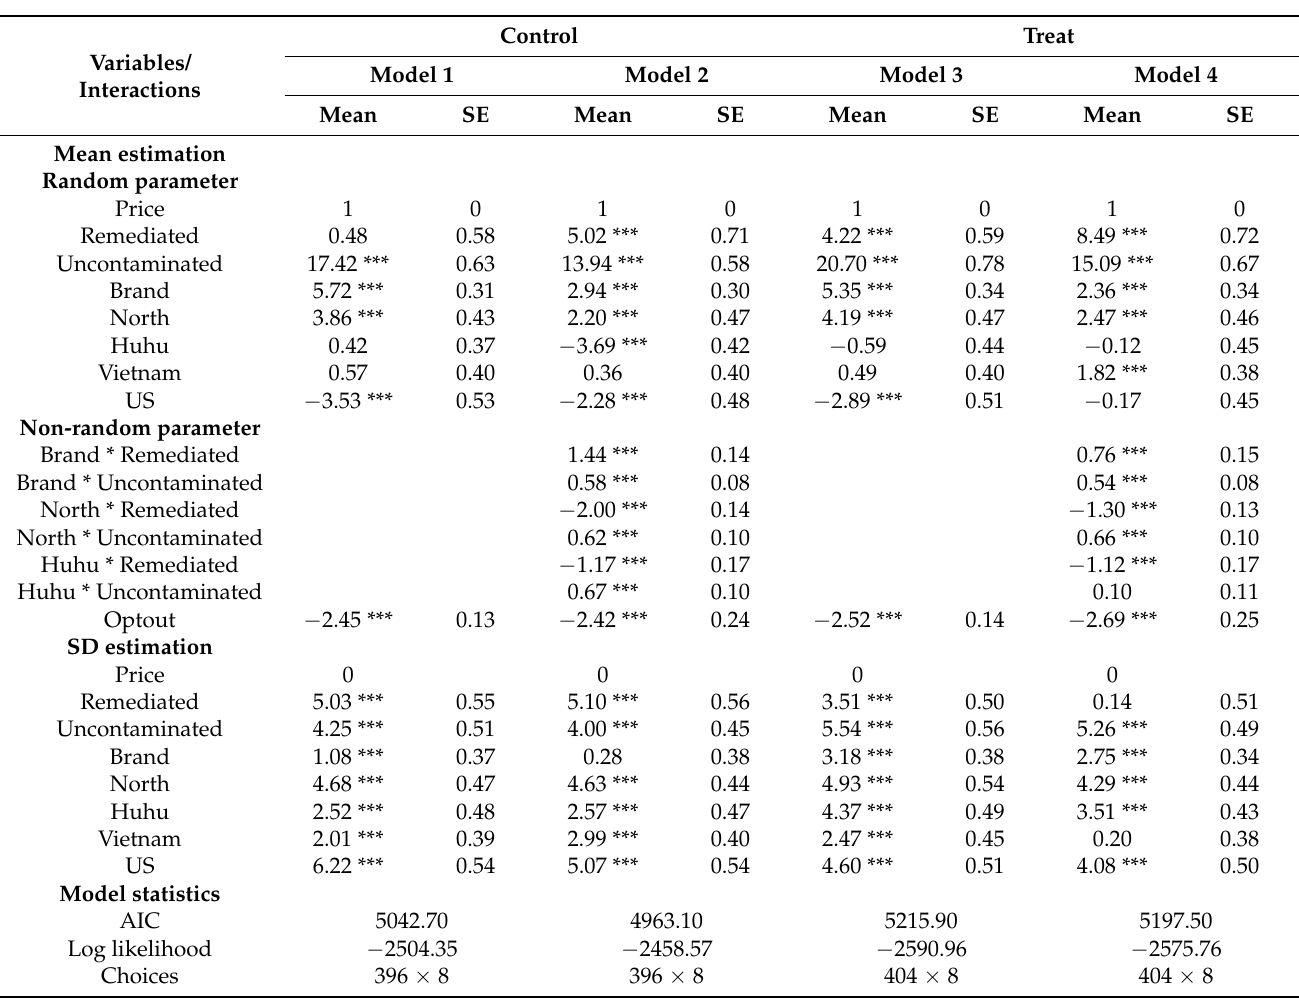
Table 4. RPL (WTP space) results of both control and treatment groups with or without interaction